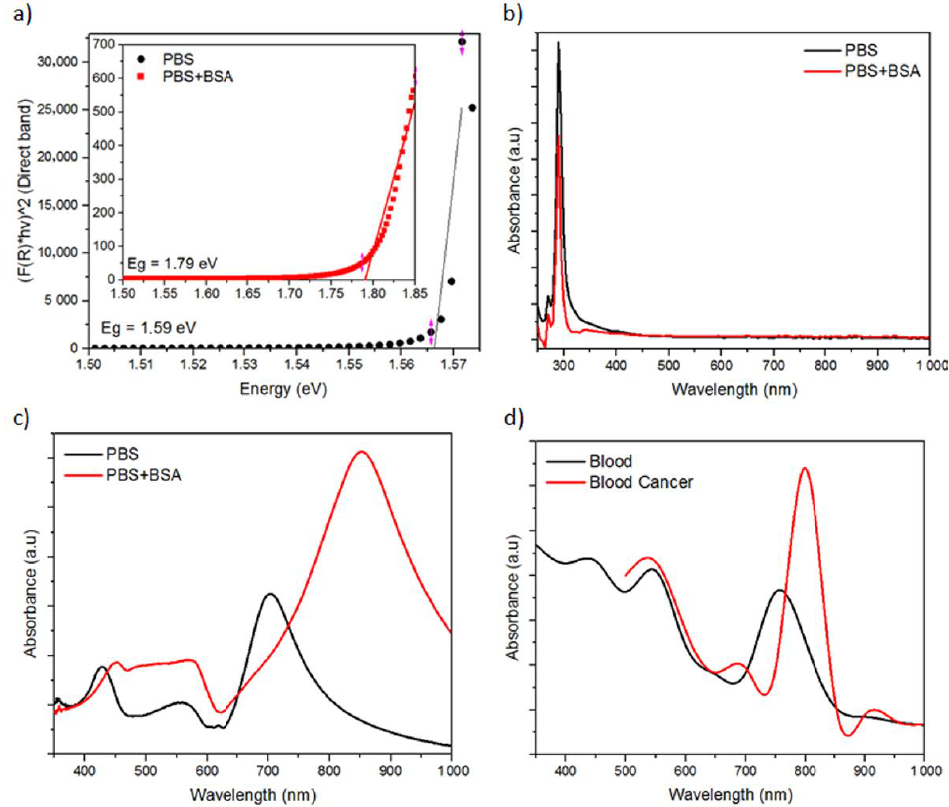
Figure 5. ( a ) The Kubelka – Munk Graph of absorbance measurements of the Ag nanosquare array; ( b ) average value of experimental results of the absorbance of the PBS and PBS+BSA media without the Ag nanosquare array electrode; ( c ) average value of experimental results of the absorbance of the PBS and PBS+BSA media with the Ag nanosquare array electrode; and ( d ) simulation results of the absorbance of the Ag nanosquare array.